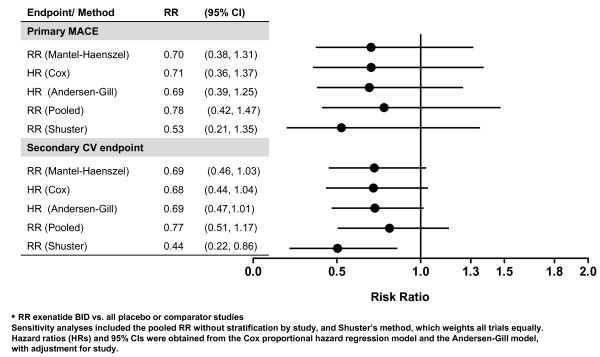
Forest plot of CV end points by statistical method.